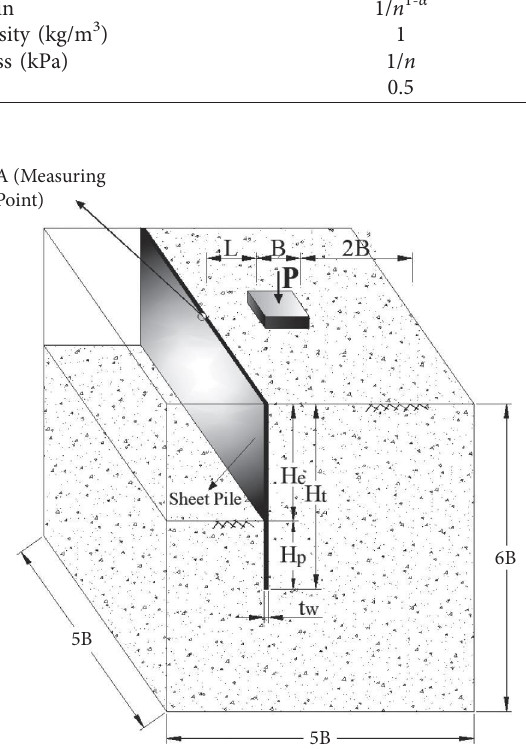
Figure 4: View of the test system.